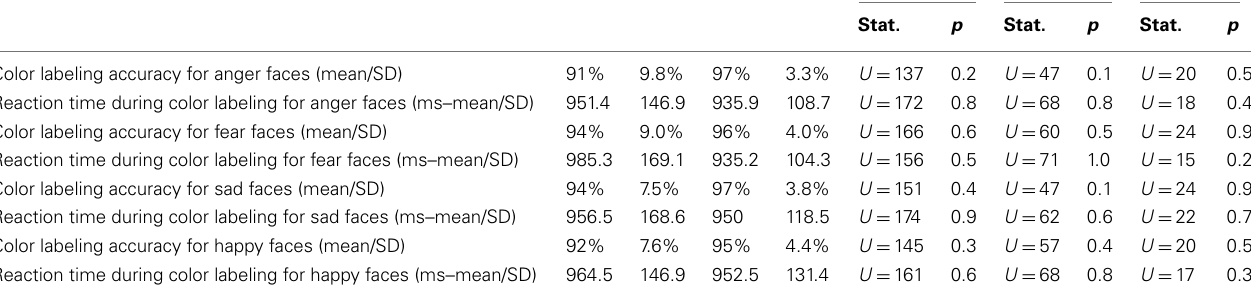
asked to use one of three fingers to press a button indicating the color of a semi-transparent foreground color flash (orange, turquoise, or yellow) that appeared during the mid 200–650